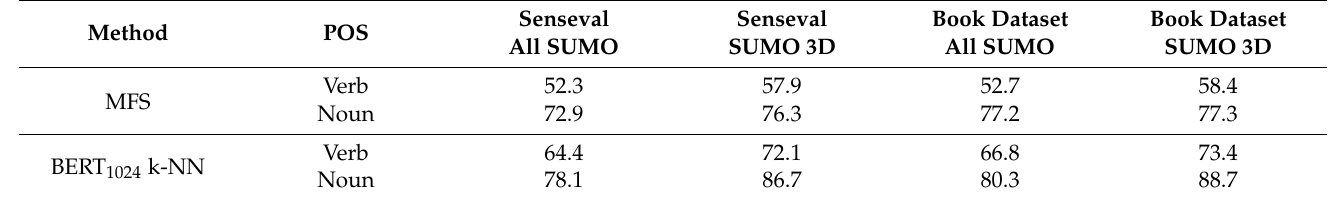
Table 5. SUMO concept disambiguation